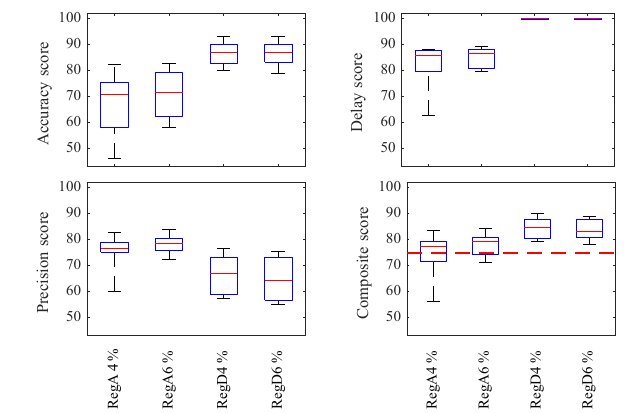
Figure 9. Box plots of PJM performance scores for a dynamic- model-controlled wind farm for all regulation signal types (RegA or RegD) with derate values of 4 and 6%. The qualification thresh- old of 75% for the composite score (red dashed line) is shown in the lower right panel. The average controlled system performance exceeds 75% for both signal types, but only the RegD cases pass all of the